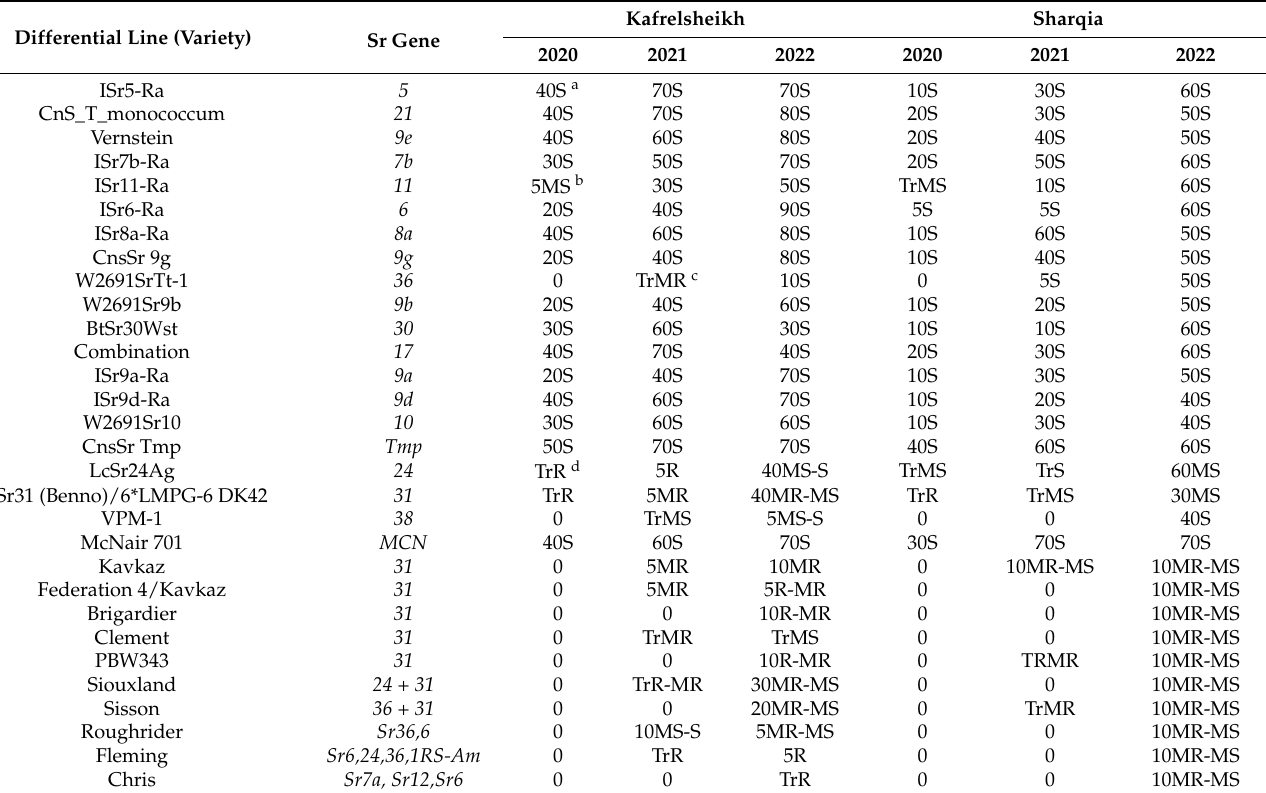
Table 4. Disease severity and reaction type of 30 wheat monogenic lines and varieties with stem rust resistance genes ( Sr ) at the two governorates during the three growing seasons.